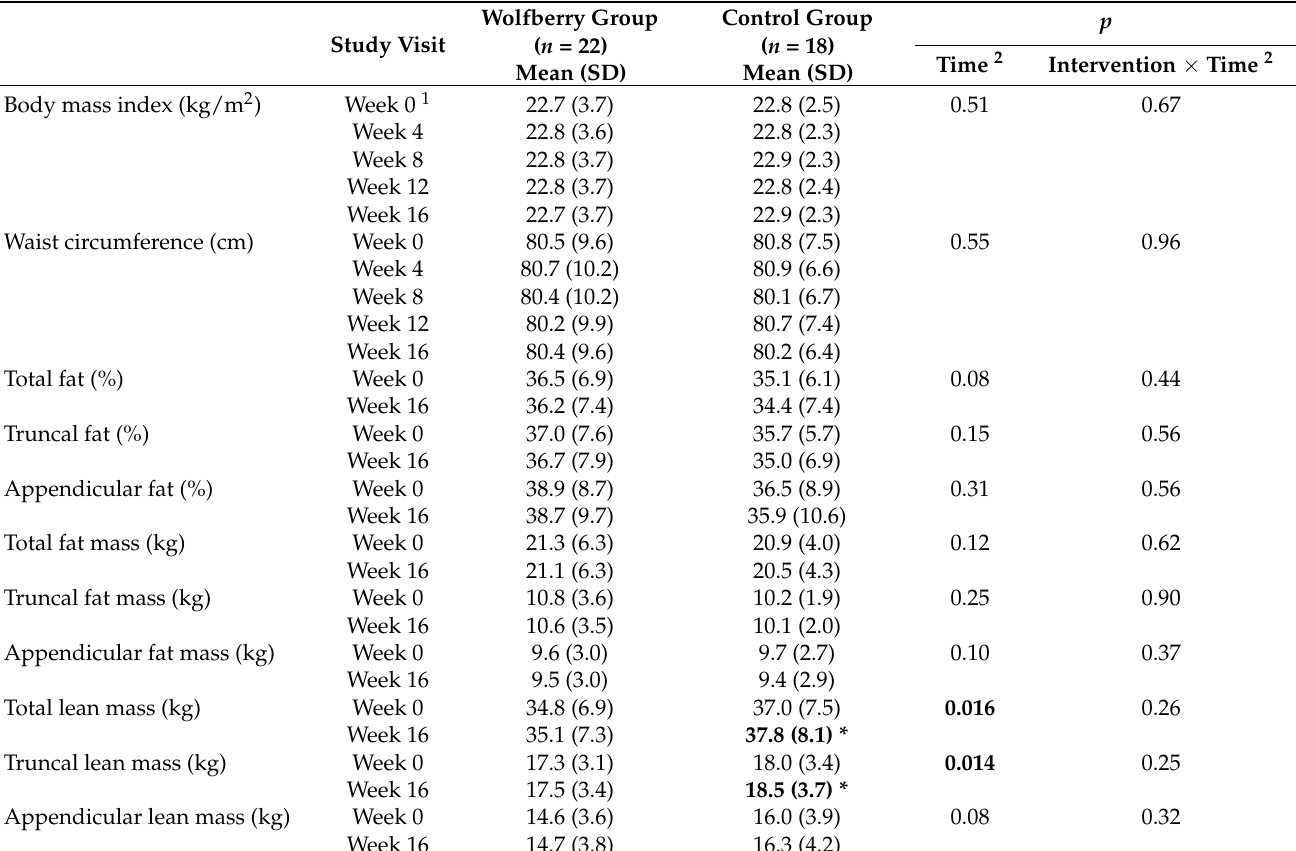
Table 3. Population anthropometric indicators and body compositions at different time points of randomized controlled